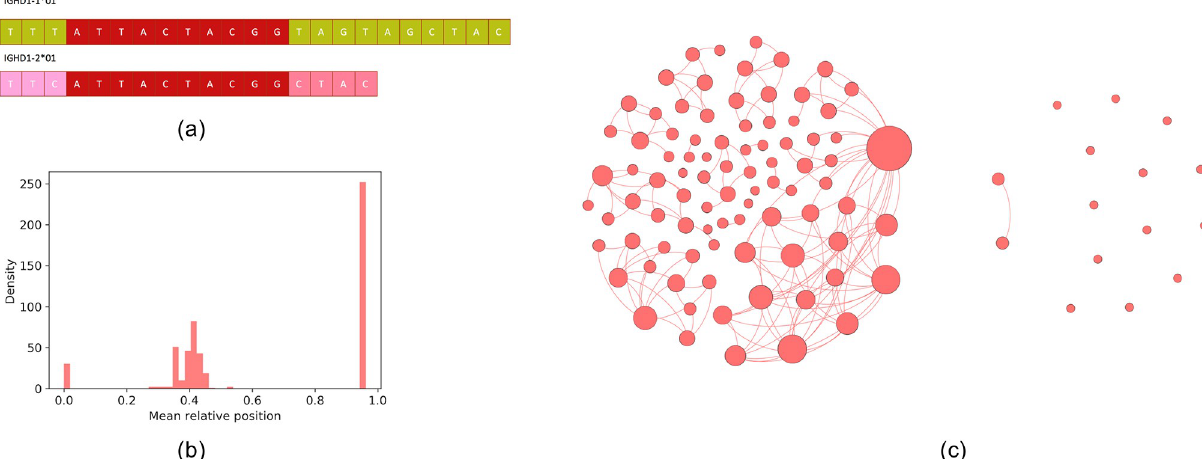
Fig 3. Details of MINING-D algorithm. (a) The 10-mer ATTACTACGG is present in two mouse D genes. (b) The mean relative positions of the extensions in the MOUSE dataset. The relative positions of the extensions form three clusters each corresponding to one of the V, D, and J gene segments. (c) Similarity graph on all extensions corresponding to D genes before filtering extensions or clique merging for the MOUSE dataset (left) and after filtering extensions and merging cliques (right). The size of a node represents its degree.